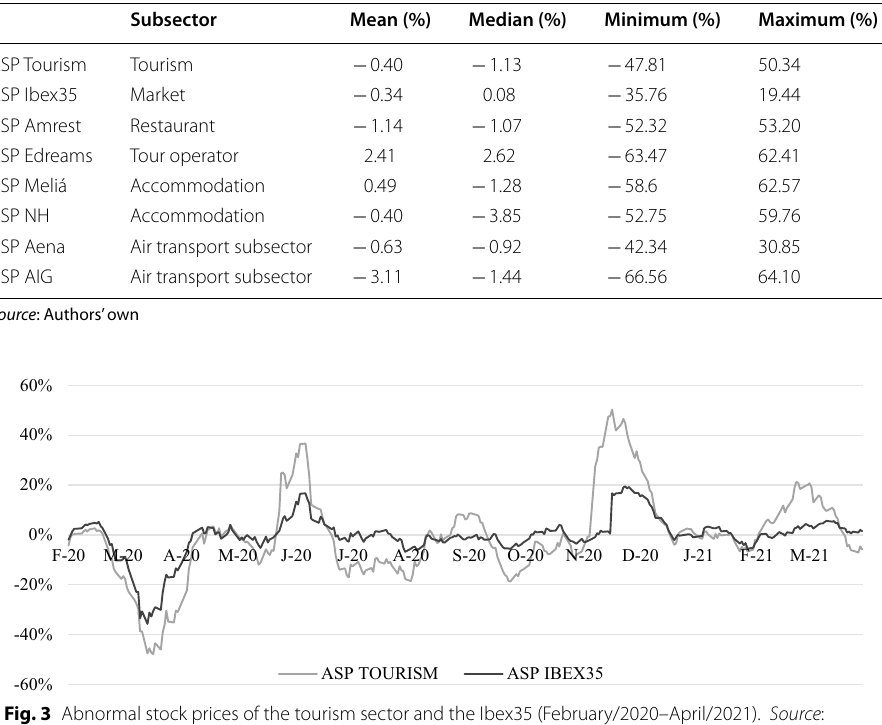
Table 2 Descriptive analysis